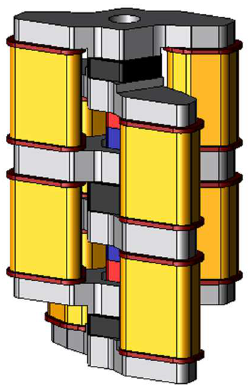
Figure 3. Structure of the two-serial model.